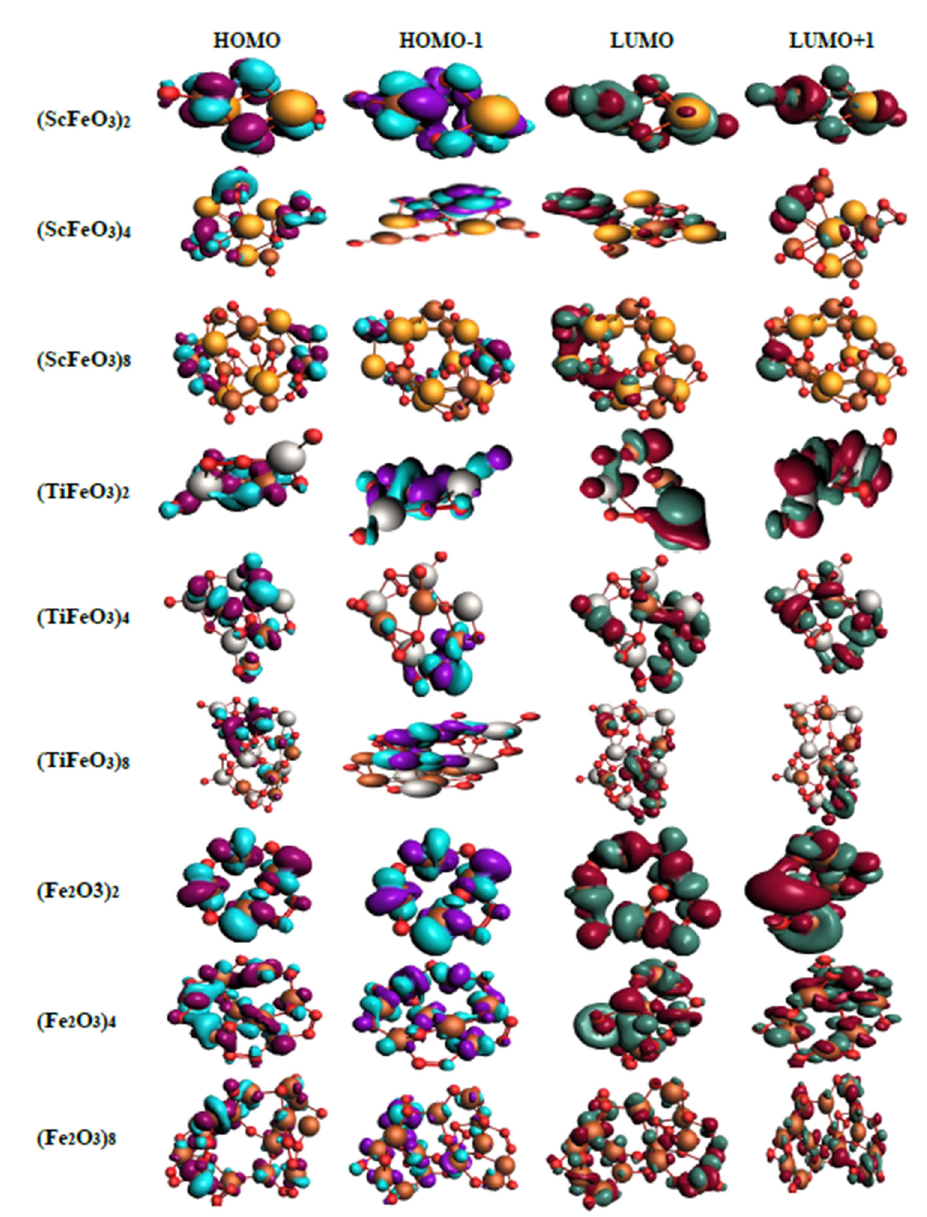
Figure 6. Iso-surface plots for highest occupied energy levels HOMO and HOMO-1 and lowest un- occupied energy levels LUMO and LUMO+1. unoccupied energy levels LUMO and